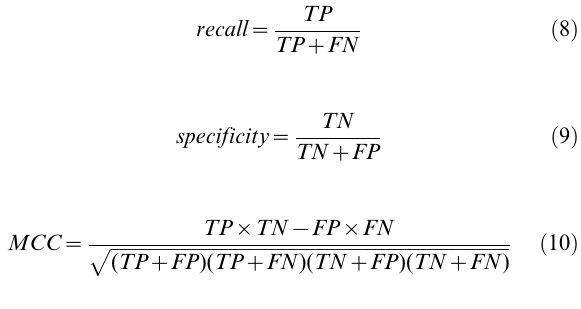
Table S5 Ranking antibody CDR single site amino acid binding to VEGF with public domain scoring functions. Table S5b, the top-ranked amino acid types and rotamers with various scoring systems. Table S6 Amino acid conformation classifications. Table S7 Atom types in protein structures. (DOC) Table S8 Statistic pairwise atomistic interaction pref- erences. (DOC) Table S9 The predicted ranking of the 20 natural amino acid types at each of the CDR amino acid positions in the 5 antibody-VEGF complex structures. (DOC) Text S1 Supplemental